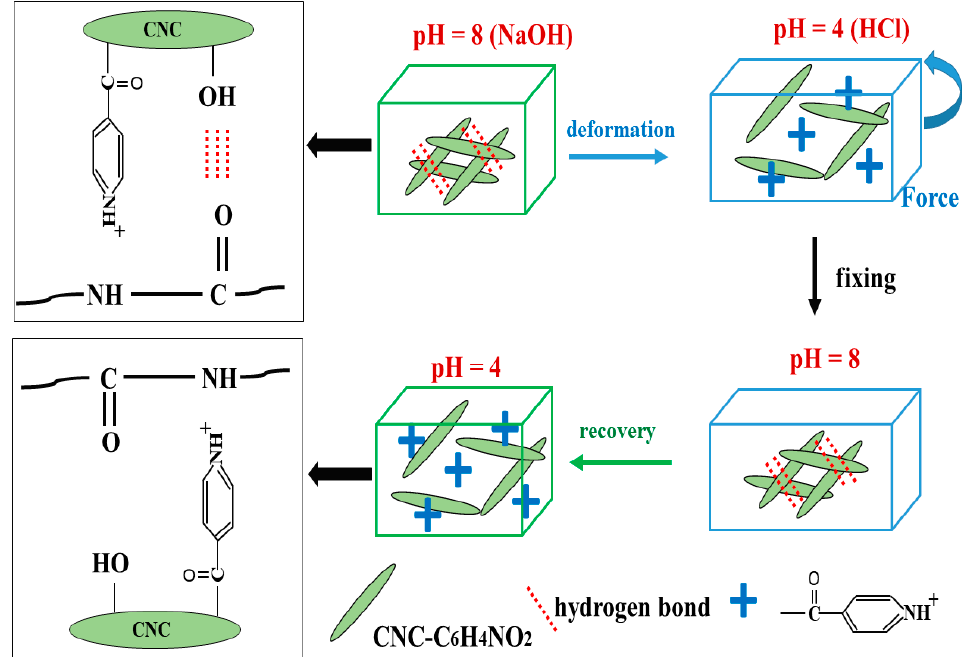
Figure 16. Schematic representation of the pH-responsive shape memory materials, which rely on a hydrogen bonding switching mechanism in the interactions between cellulose nanocrystals (CNC − C 6 H 4 NO 2 ) within polymer matrix upon immersion in HCl solution (pH = 4) or NaOH solution (pH = 8). Adapted from [23].